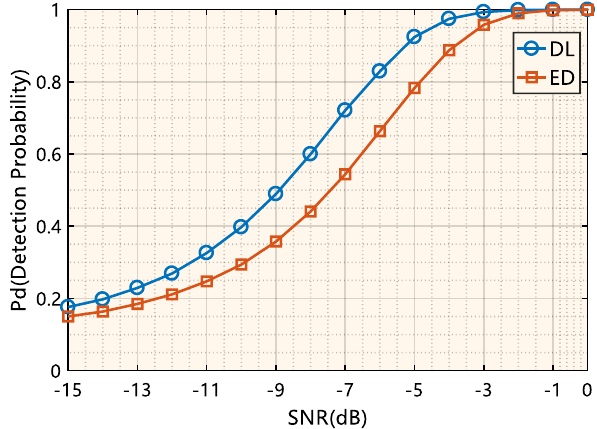
Figure 8. The performance of the deep-learning-based signal detector with a varying signal-to-noise ratio (SNR).